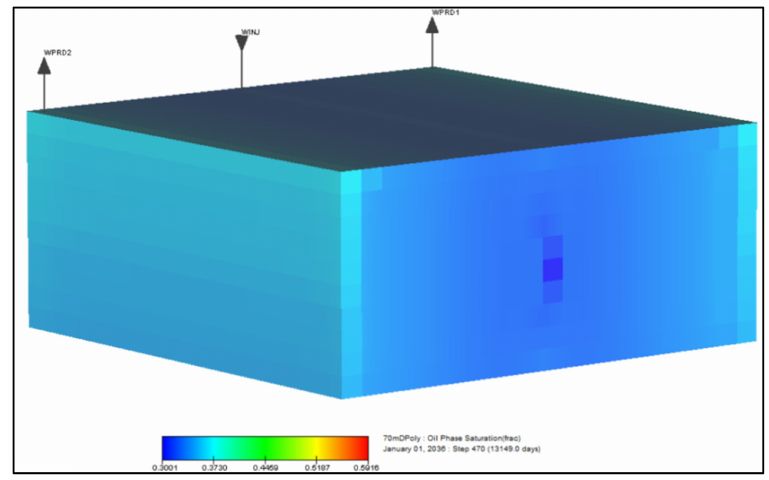
Figure 16. Reservoir distribution of residual oil saturation at the end of the calculation period when the polymeric solution is displaced.